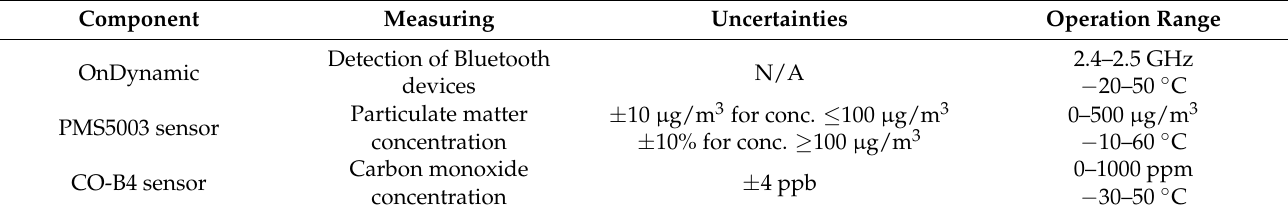
Table 1. The monitoring equipment set used for the study.